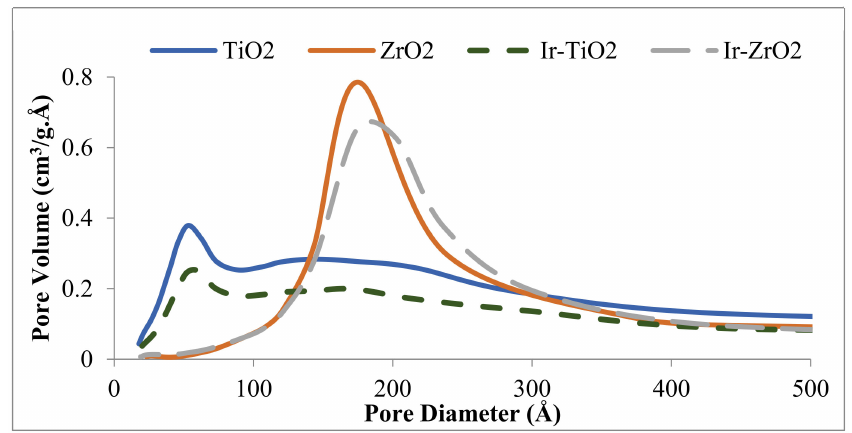
Figure 2. Pore size distributions of the materials.